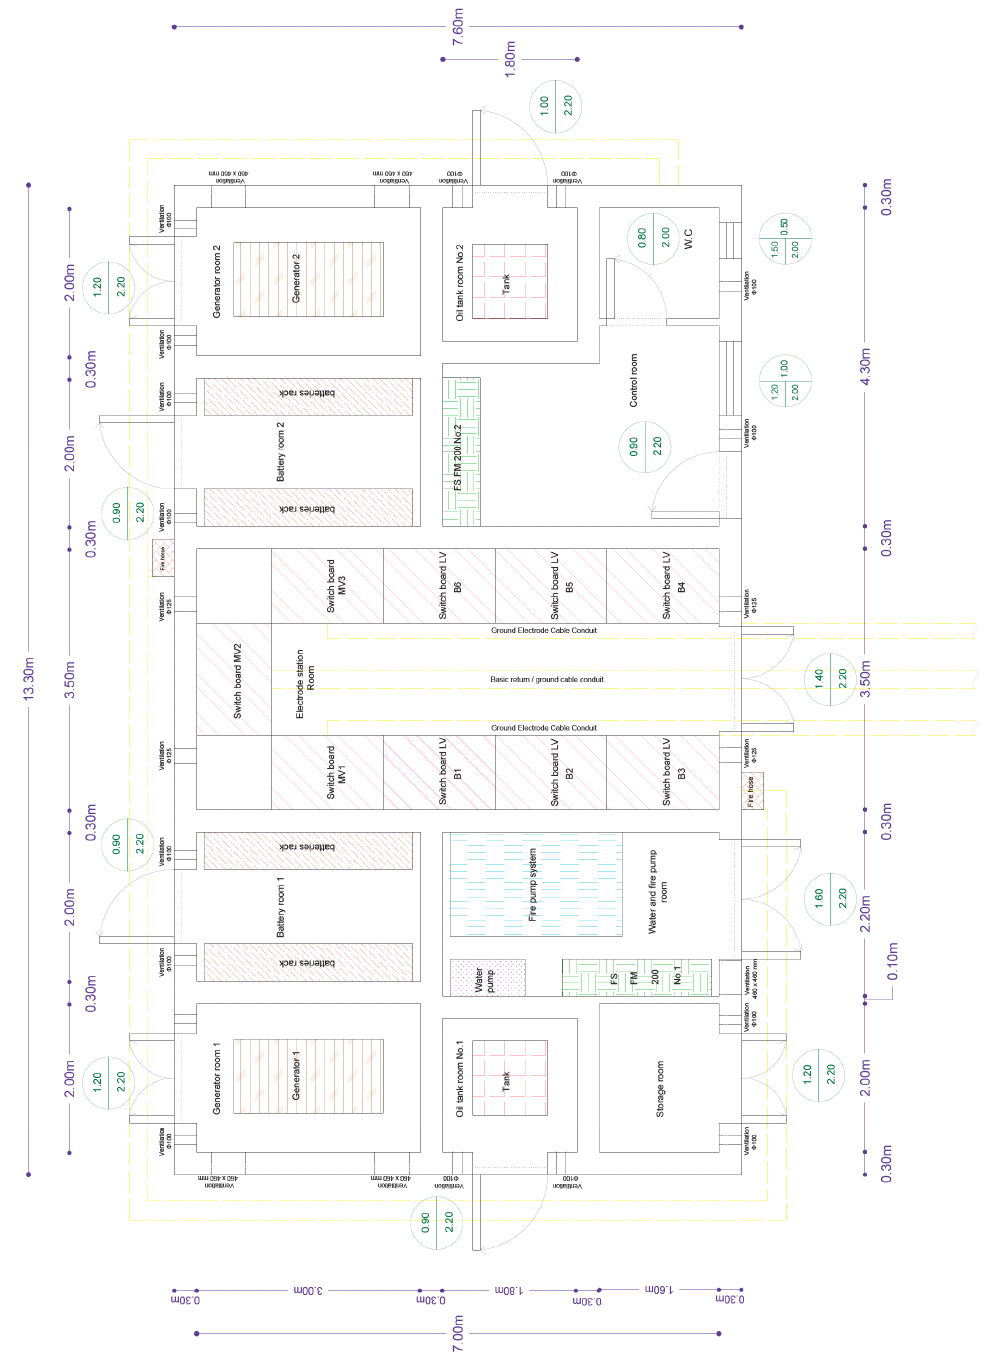
Figure 6. Layout of the electrode station building in Stachtoroi, Saronic Gulf, Attica in case of the stand-alone photovoltaic (SAPV) system with back-up diesel generators.